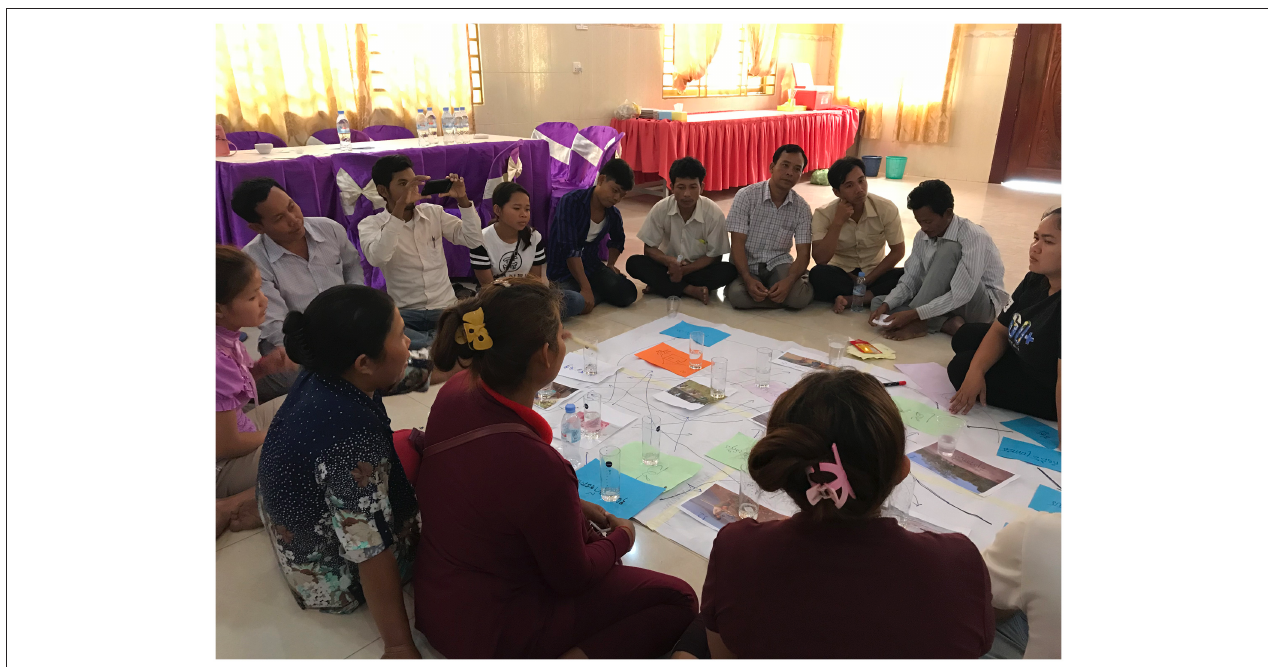
FIGURE 2 | LIVES Cambodia participatory modeling